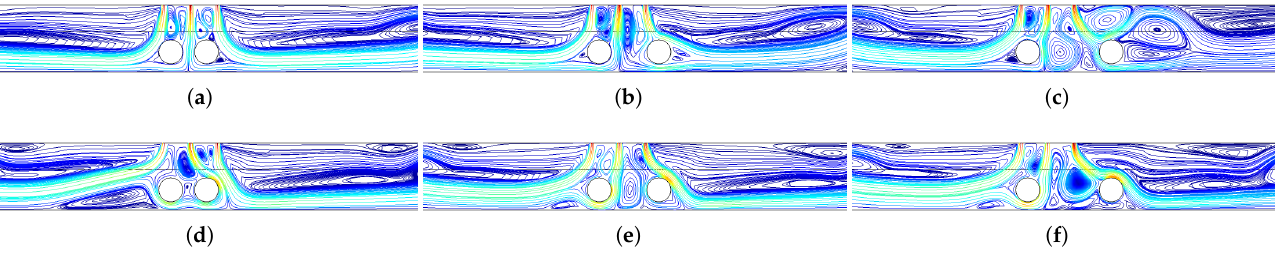
Figure 8. Impacts of distance between the hot cylinders on the streamline variations at two different Rew (Re = 300, Da = 0.01, HNF-2%). ( a ) Sc = Rc, Rew = 0; ( b ) sc = 3Rc, Rew = 0; ( c ) sc = 5Rc, Rew = 0; ( d ) sc = Rc, Rew = − 500; ( e ) sc = 3Rc, Rew = − 500; ( f ) sc = 5Rc, Rew = −